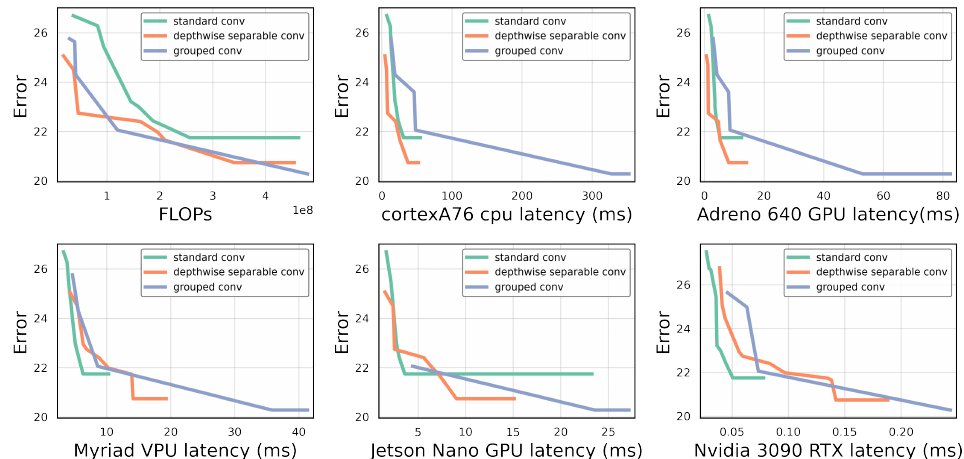
Figure 6. While grouped convolutions should, in theory, be able to combine advantages from depthwise and standard convolutions, current implementation across various hardware accelerators and inference platforms fail to leverage these advantages, making grouped convolutions not an optimal